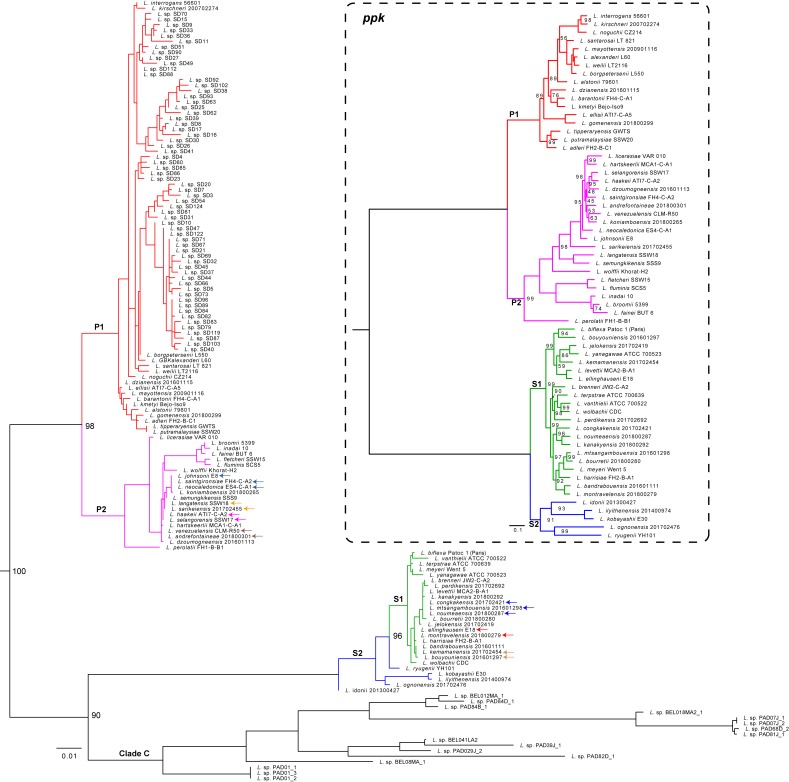
Phylogenetic tree based on the 16S rRNA and ppk sequences to evaluate the diversity within the Leptospira genus.In addition to the 16S rRNA sequences from the 64 genomes investigated in the present study, those from uncultured strains from the Peruvian Amazon (Clade C) [26] and from insectivorous bats from eastern China [27] were added. The branches are colored according to their belonging to the four main subclades: P1 (red), P2 (purple), S1 (green) and S2 (blue), while the strains of the “clade C” are in black. For the sake of clarity, the bootstrap values are only indicated for the nodes that correspond to the major splits. A tree constructed with the ppk gene sequences is included in the dashed box for comparison. In this case, all bootstrap values less than 100 are indicated at the different nodes.